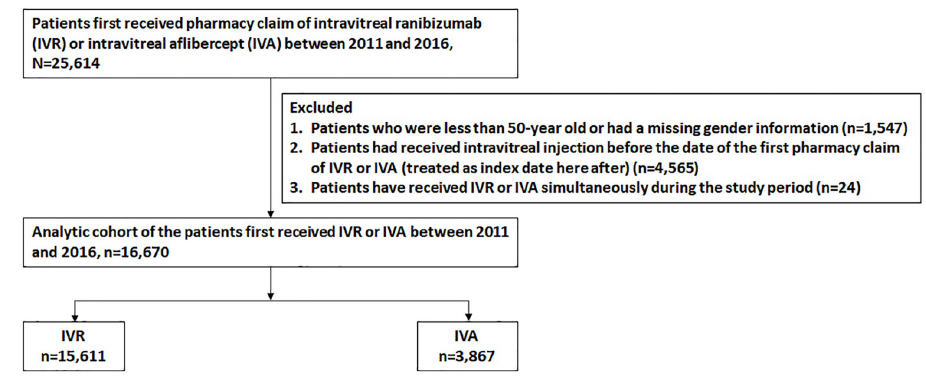
Fig 1. Flowchart of patient selection. IVA = intravitreal aflibercept; IVR = intravitreal ranibizumab.